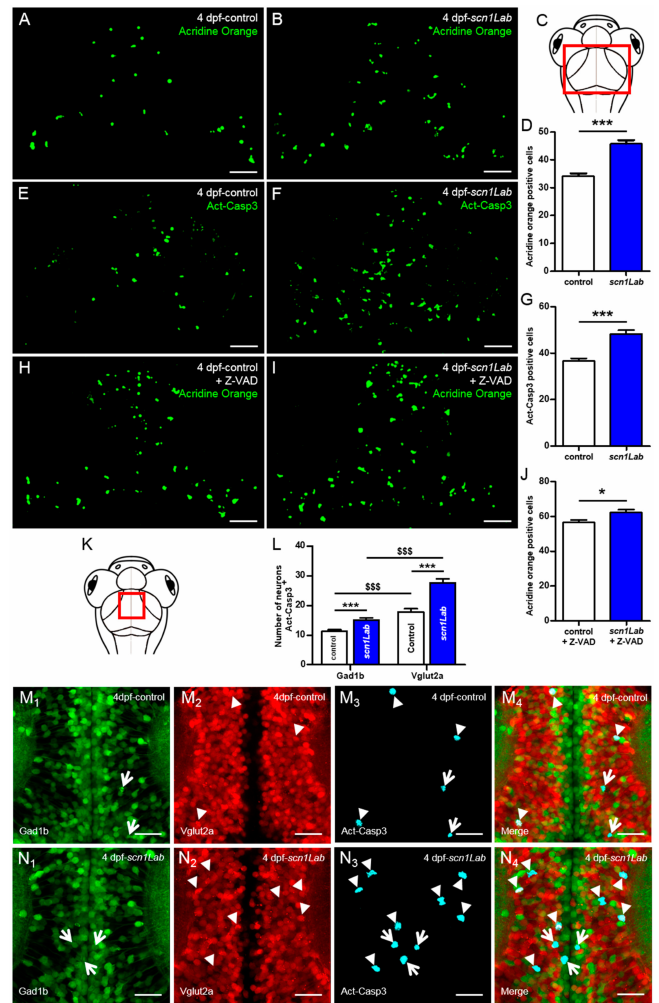
Figure 4. Increased neuronal death in Scn1Lab-depleted larvae. ( A , B ) Dorsal view of 4 dpf living control ( A ) ( N = 15) and scn1Lab ( B ) ( N = 15) larvae stained with acridine orange; 100 µ m stack. Scale bar 40 µ m. ( C ) Dorsal view schematic of 4 dpf larva. The red rectangle shows the region of interest for global cell death quantification. ( D ) Number of acridine orange-positive cells in 4 dpf brain. ( E , F ) Dorsal view of 4 dpf control ( E ) ( N = 24) and scn1Lab ( F ) ( N = 22) brain stained with activated caspase-3 antibody; 100 µ m stack. Scale bar 40 µ m. ( G ) Number of activated caspase-3-positive cells in 4 dpf brain. ( H-I ) Dorsal view of 4 dpf Z-VAD-treated control ( H ) ( N = 18) and scn1Lab ( I ) ( N = 16) larvae stained with acridine orange; 100 µ m stack. Scale bar 40 µ m. ( J ) Number of acridine orange-positive cells in 4 dpf brain. ( K ) Dorsal view schematic of 4 dpf larva. The red rectangle shows the region of interest for activated caspase-3 signal colocalization with inhibitory and excitatory neurons quantification. ( L ) Number of inhibitory (Gad1b:GFP) and excitatory (Vglut2a:DsRed) neurons also showing activated caspase-3 labelling in control and scn1Lab larvae. ( M 1-4 , N 1-4 ) Dorsal view of 4 dpf Tg[Gad1b:GFP; Vglut2a:DsRed] control ( M 1-4 ) ( N = 14) and scn1Lab ( N 1-4 ) ( N = 14) brain stained with activated caspase-3 antibody; representative 15 µ m stack. Scale bar 10 µ m. ( M 1 ,N 1 ) Inhibitory neurons (Gad1b:GFP) in control ( M 1 ) and scn1Lab ( N 1 ) larvae. ( M 2 ,N 2 ) Excitatory neurons (Vglut2a:DsRed) in control ( M 2 ) and scn1Lab ( N 2 ) larvae. ( M 3 ,N 3 ) Activated caspase-3 staining in control ( M 3 ) and scn1Lab ( N 3 ) larvae. ( M 4 ,N 4 ) Merged images of control ( M 4 ) and scn1Lab ( N 4 ) larvae. Excitatory neurons with activated caspase-3 expression are shown by arrowheads, while inhibitory neurons with activated caspase-3 expression are shown by arrows. Images were all acquired with an SP8 Leica laser scanning confocal microscope equipped with 40x / water 1.1 objective. N = number of embryos. Error bars on all graphs represent standard error mean (SEM). *, p < 0.05; ***, p < 0.001 indicate a statistically significant difference between control and scn1Lab larvae. A statistically significant difference between inhibitory and excitatory neuronal population is indicated as $$$, p < 0.001. p -values were determined using Student’s unpaired t